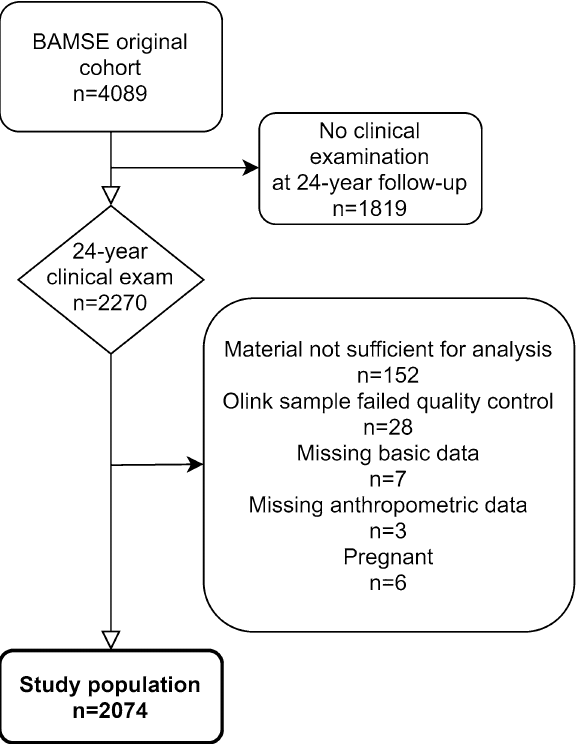
Figure 1. Flow chart of the study population from the BAMSE